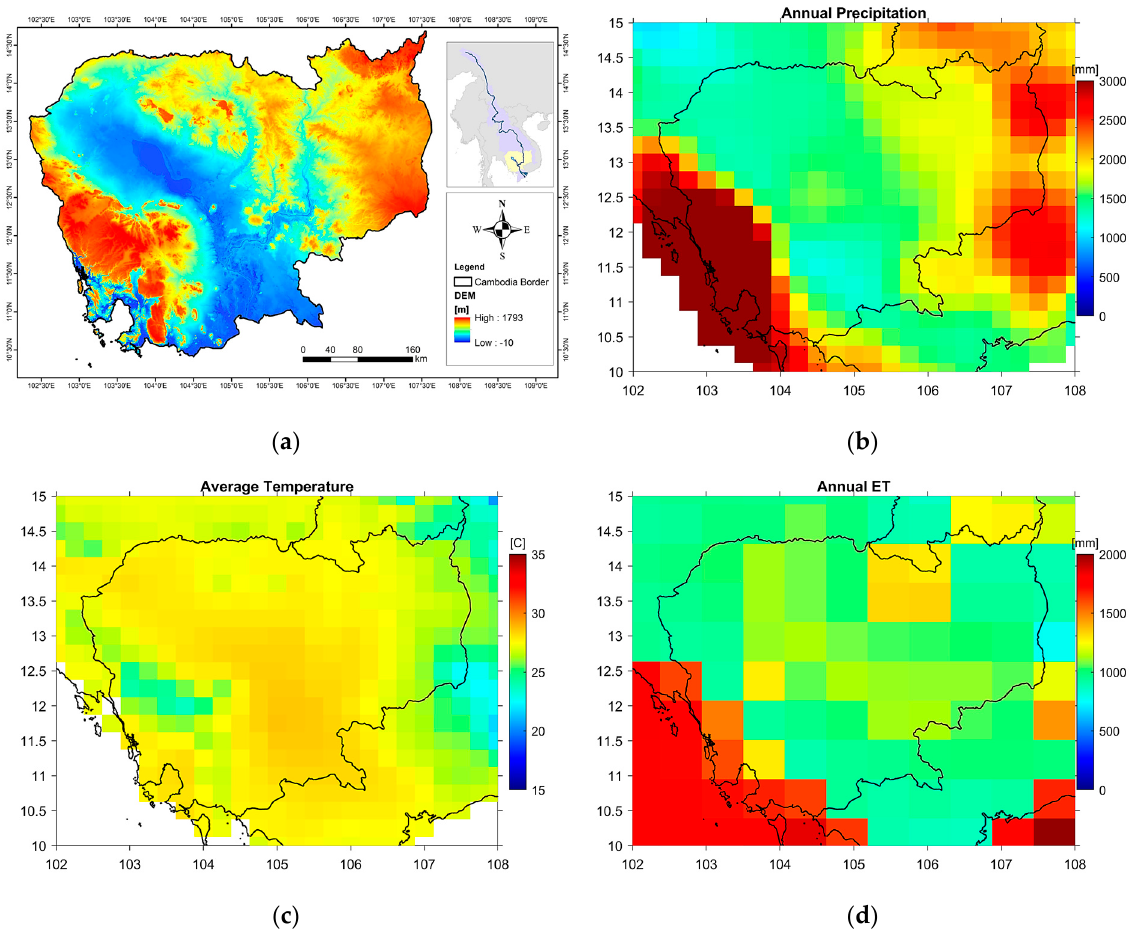
Figure 1. Map of Cambodia showing: ( a ) Digital Elevation Model; ( b ) Average annual precipitation over Cambodia from APHRODITE dataset; ( c ) Average annual temperature over Cambodia from APHRODITE dataset; ( d ) Average annual evapotranspiration over Cambodia from JRA − 55 dataset.